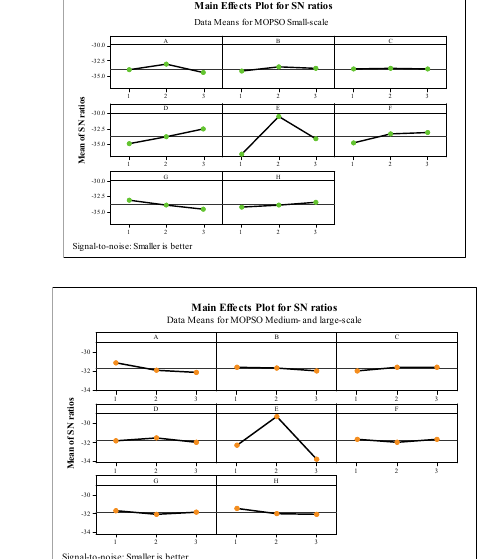
Main Effects Plot for SN ratios Data Means for MOPSO